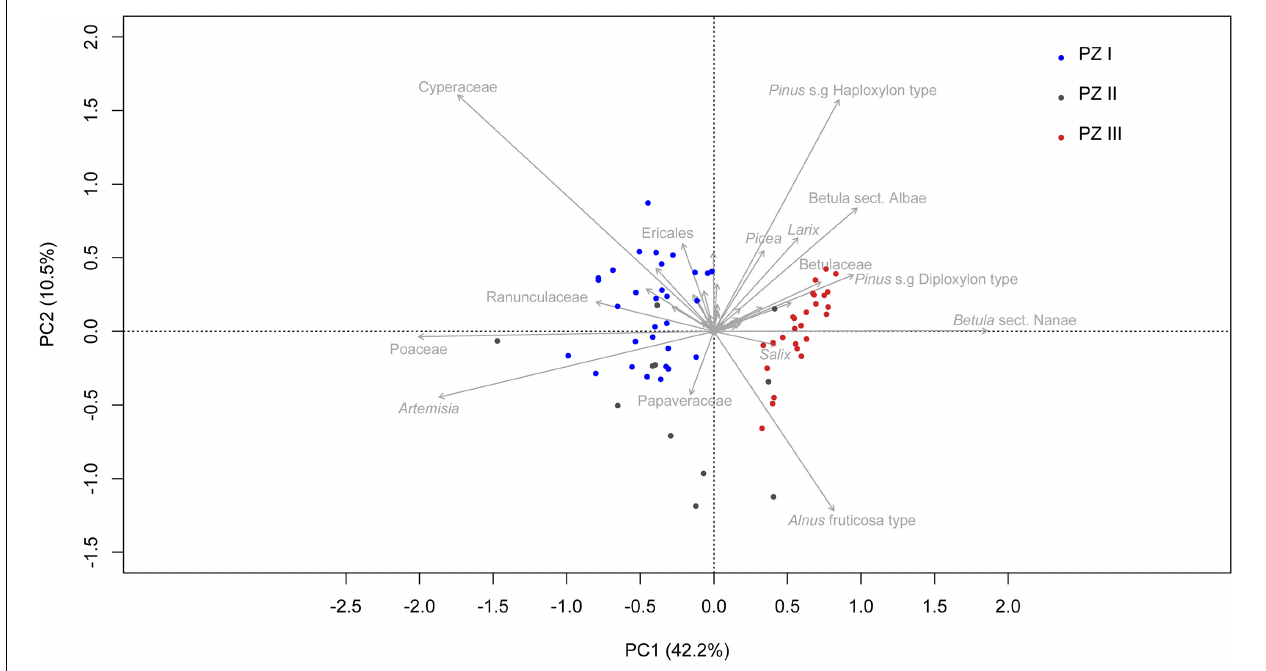
most common families among the dataset that represent 90% of the reads are Salicaceae (52%), Rosaceae (13%), Betulaceae (12%), Saxifragaceae (6%), Ericaceae (4%), Pinaceae (3%), and Asteraceae